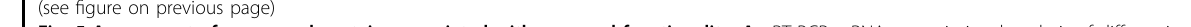
Fig. 5 Assessment of genes and proteins associated with neuronal functionality. A qRT-PCR mRNA transcriptional analysis of differentiated hMSCs for genes associated with functional behaviour of DAergic neuronal cells. Data points represent the means ± SD ( n = 3), * p < 0.001 vs. control untreated cells. B Flow cytometric enumeration of number of cells positive for (i) dopamine transporter protein, a protein responsible for release of dopamine neurotransmitter through vesicles and (ii) synaptophysin protein which is responsible for the formation of synapse between two neuronal cells. Data points represent the means ± SD ( n = 3), * p < 0.001 vs. control untreated cells. C Immuno fl orescence assay to show the expression of TH and DAT proteins in hMSCs pre-differentiation and post-differentiation into DAergic neuronal